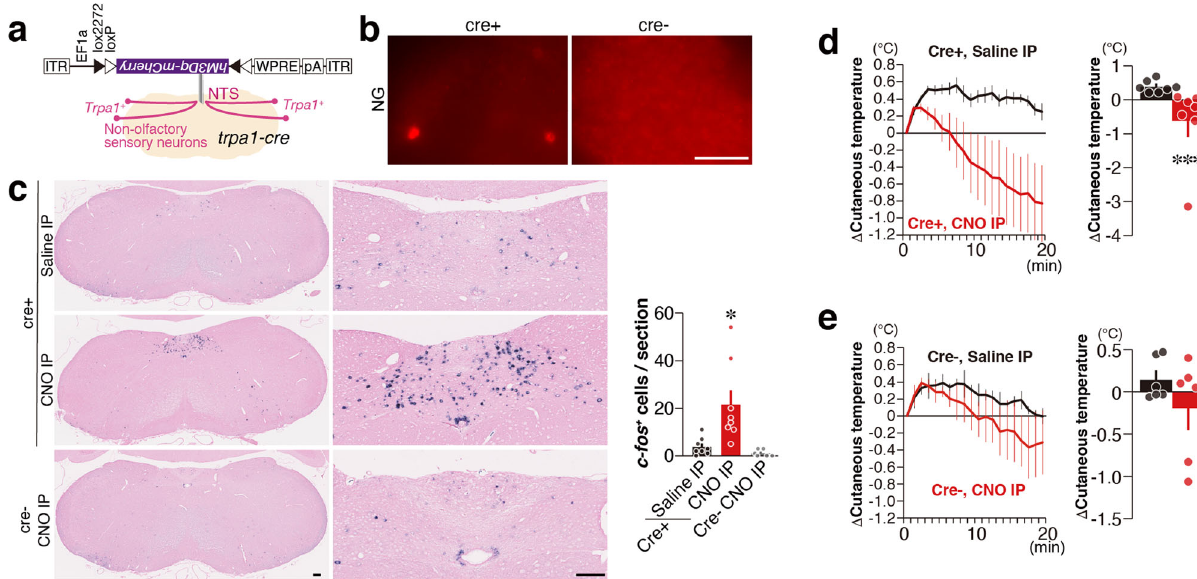
Fig. 6 Hypothermia induced by the Trpa1 + neurons projecting to the NTS. a , b The experimental design of the chemogenetic activation of Trpa1 + neurons projecting to the NTS ( a ) and representative retrograde-labeled mCherry expression in the VG in Trpa1-Cre and control mice ( b ). c Representative images of medulla (left), magni fi ed views in the NTS (middle), and quanti fi cation (right) of c-fos + cells in the NTS after CNO administration are shown ( n = 8 for Trpa1-Cre + /sal and Trpa1-Cre + /CNO and n = 6 for Trpa1-Cre − /CNO, p = 0.0135 between Trpa1-Cre + /sal and Trpa1-Cre + /CNO, and p = 0.5335 between Trpa1-Cre + /sal and Trpa1-Cre − /CNO). d , e Temporal and mean cutaneous temperature after administration of saline (black) and CNO (red) are shown for hM3Dq-infected Trpa1-Cre ( d ; n = 7 each, p = 0.0003) and control mice ( e ; n = 6 each, p = 0.1562). Data are shown as mean ± SEM. Kruskal – Wallis with Dunn ’ s multiple test ( c ), one-tailed, Mann – Whitney U test ( d ), and one-tailed, Wilcoxon test ( e ) were used to assess signi fi cance; * p < 0.05; ** p < 0.01; *** p < 0.001. Scale bars, 100 µ